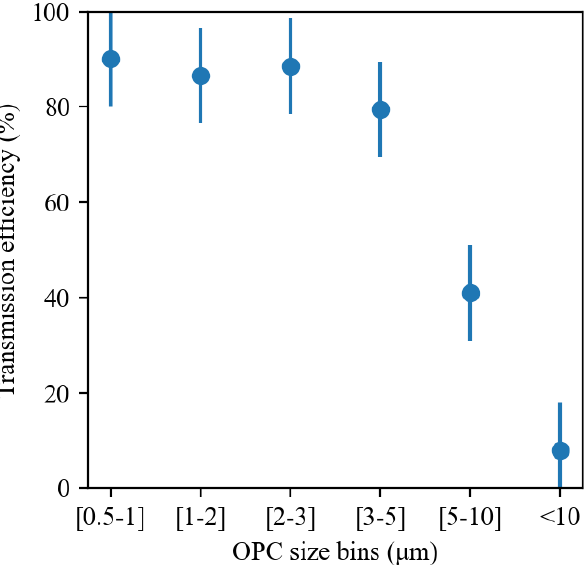
Figure A2. Transmission efficiency as a function of particle size for the sampling system upstream of PINE. The measurements were made with an OPC (MetOne, GT 526S) with an accuracy of ±